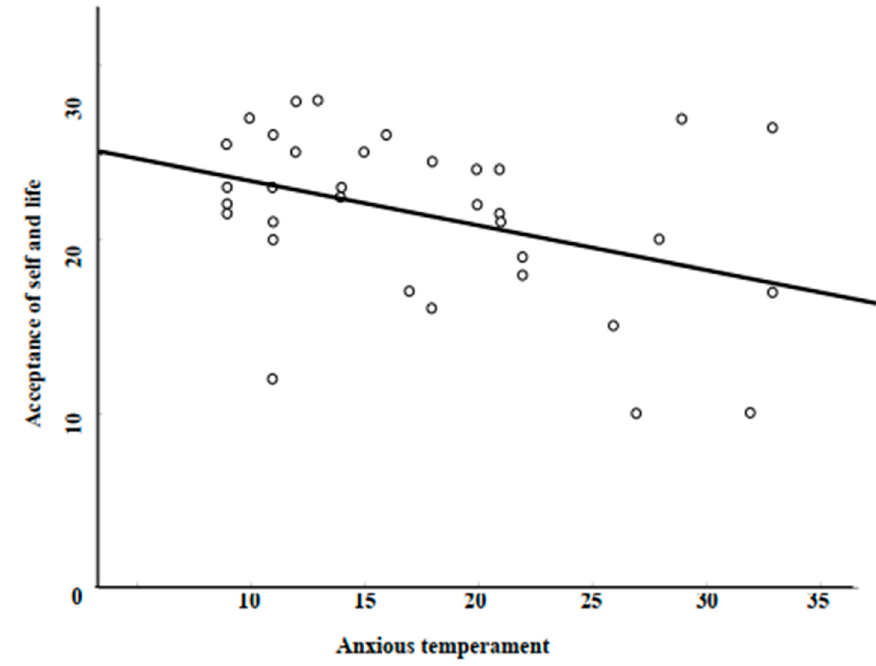
Figure 1. The correlation between anxious temperament and “acceptance of self and life” in individuals with BD during the COVID ‐ 19 pandemic.